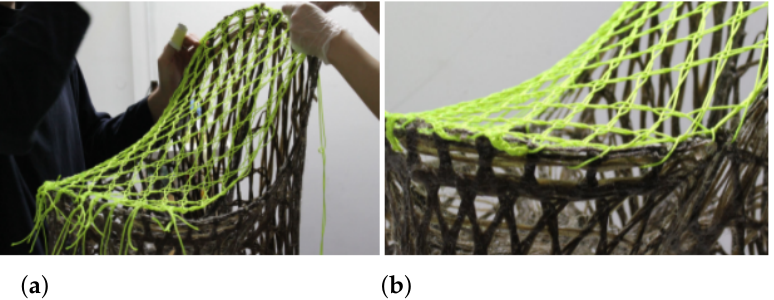
Figure 17. Assembly ( a ) Attaching the laced seat to the cured chair with a lashing. ( b ) Detail of the seat